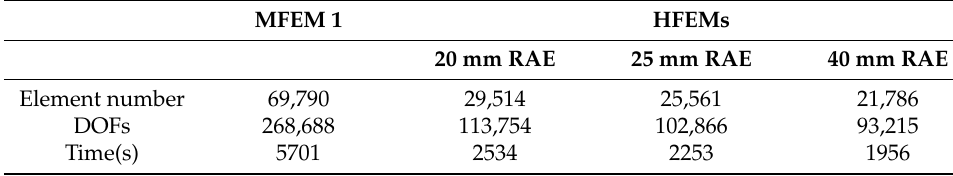
Table 2. Comparison of calculation efficiency between MFEM 1 and